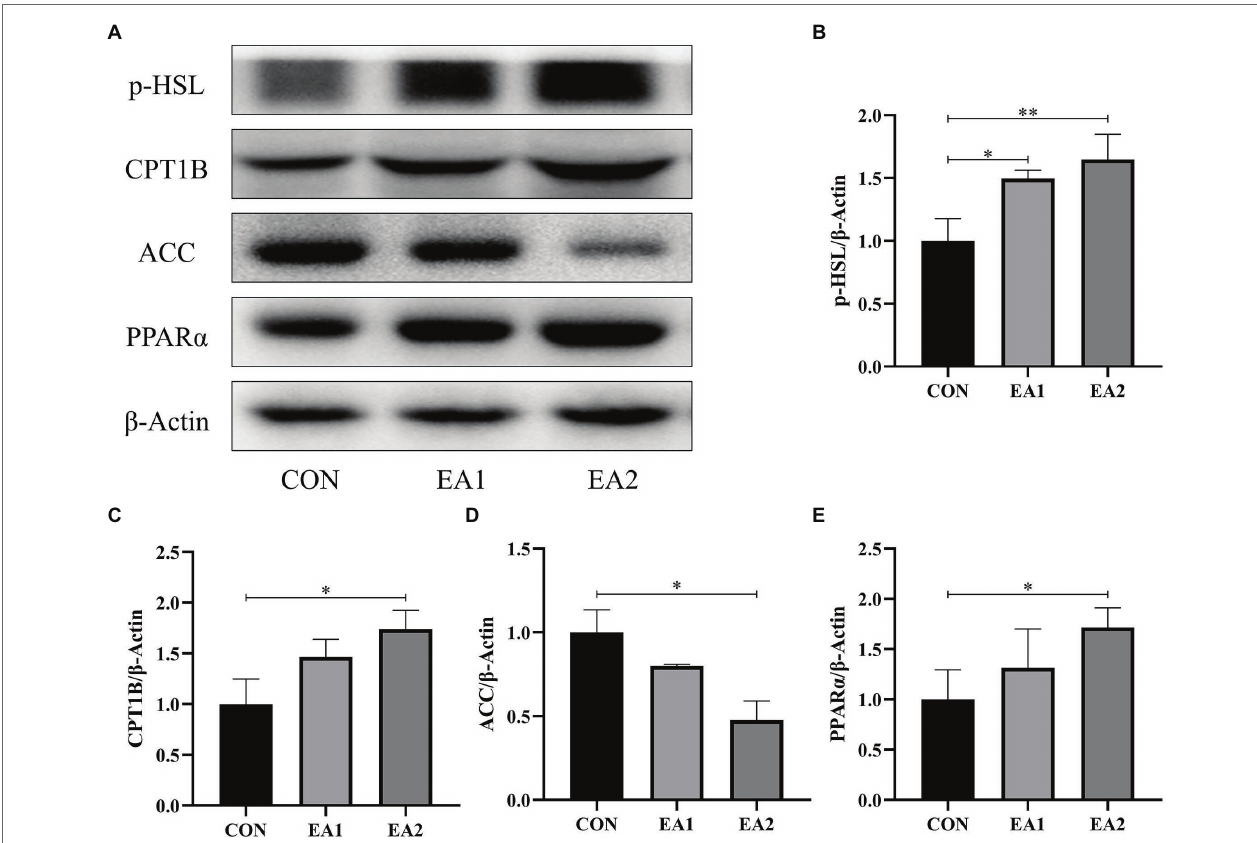
FIGURE 4 | Effects of EA supplementation on lipid-metabolism-related protein abundances. (A) The liver samples were analyzed by Western blotting using antibodies against phospho-hormone-sensitive lipase (p-HSL), carnitine palmitoyltransferase 1B (CPT1B), acetyl-CoA carboxylase (ACC), peroxisome proliferator- activated receptor alpha ( PPAR α ), and β -Actin (used as the protein loading control). (B) The p-HSL/ β -Actin ratio in the liver. (C) The CPT1B/ β -Actin ratio in the liver. (D) The ACC/ β -Actin ratio in the liver. (E) The PPAR α / β -Actin ratio in the liver. * p < 0.05 and ** p < 0.01 represent significant differences compared with the control